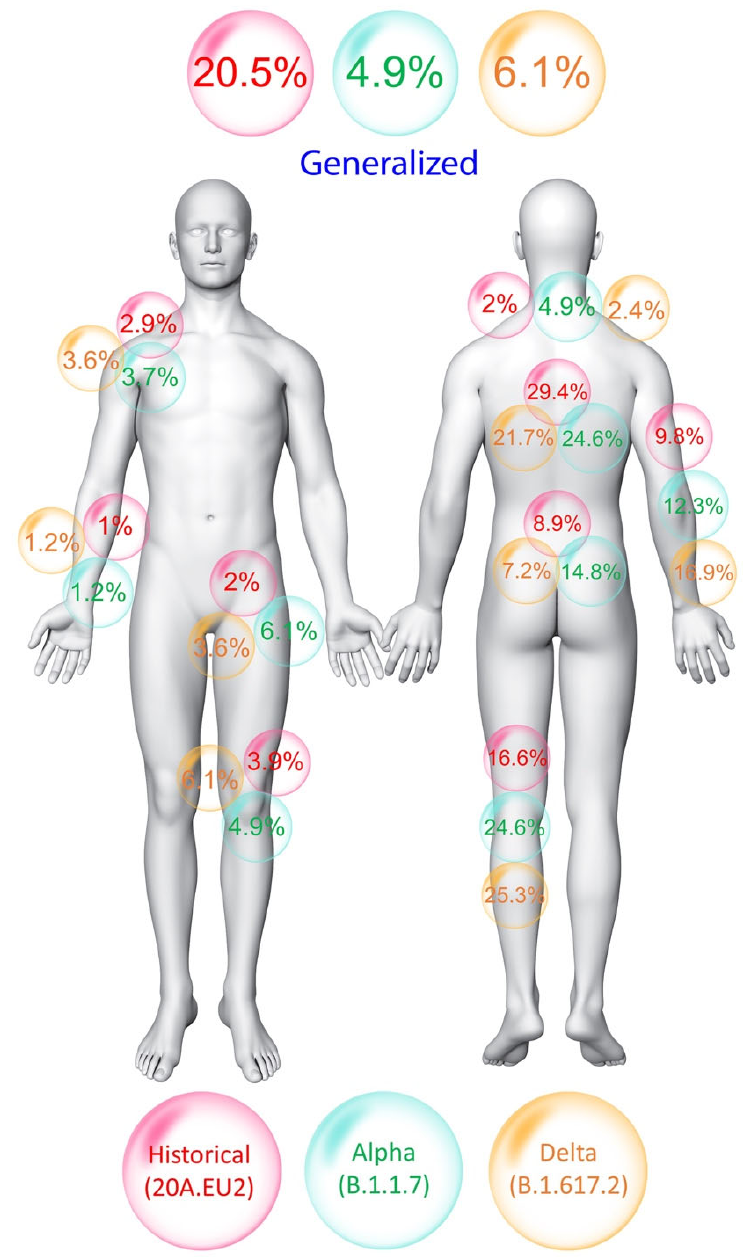
Figure 1. Location of musculoskeletal post-COVID pain symptoms six months after hospital discharge in individuals infected with the historical, Alpha or Delta SARS-CoV-2 variant. Clinical and hospitalization data between patients with and without musculoskeletal post-COVID pain by SARS-CoV-2 variant are shown in Table 1. Patients with musculoskeletal post-COVID pain infected with the Alpha variant were older and showed a lower number of onset symptoms at hospital admission and a longer stay of hospitalization (all, p < 0.01) than patients who reported musculoskeletal post-COVID pain but were infected with the historical or Delta variant. In addition, subjects with musculoskeletal post-COVID pain who were infected by the historical variant exhibited higher depressive levels than those infected with the Alpha or Delta variants ( p = 0.001). Anxiety levels ( p = 0.1) and sleep quality ( p = 0.448) were not significantly different among the three SARS-CoV-2 variants (Table